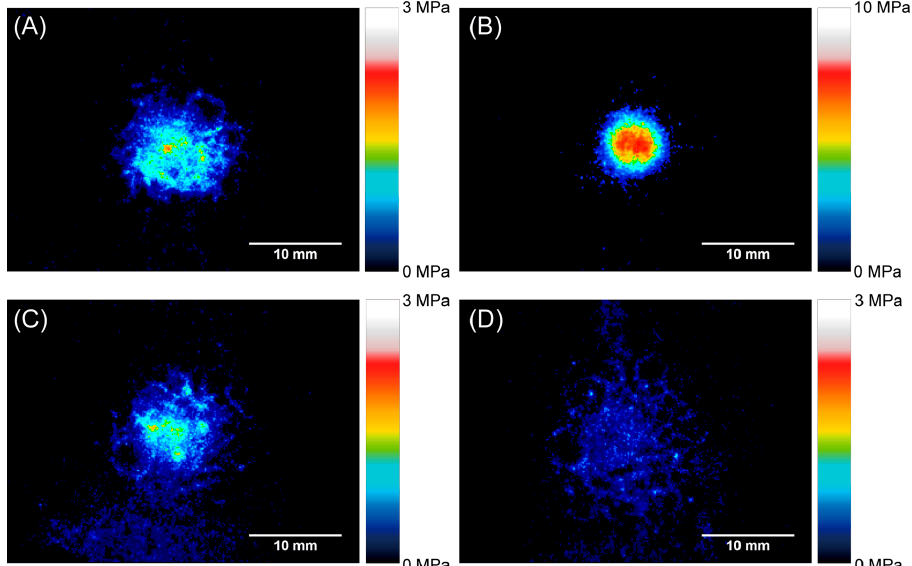
Figure 4. Pressure distribution obtained using pressure measurement films. ( A ) AP32, ( B ) AP16, ( C ) GFRTP, and ( D ) CFRTP.